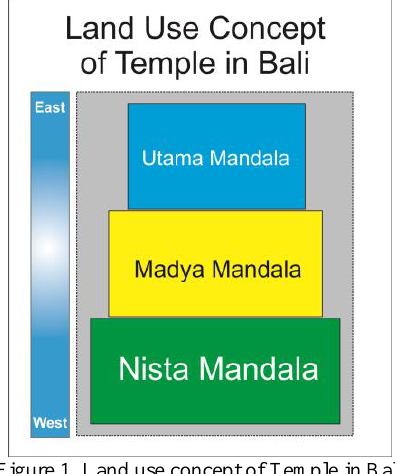
Figure 1. Land use concept of Temple in